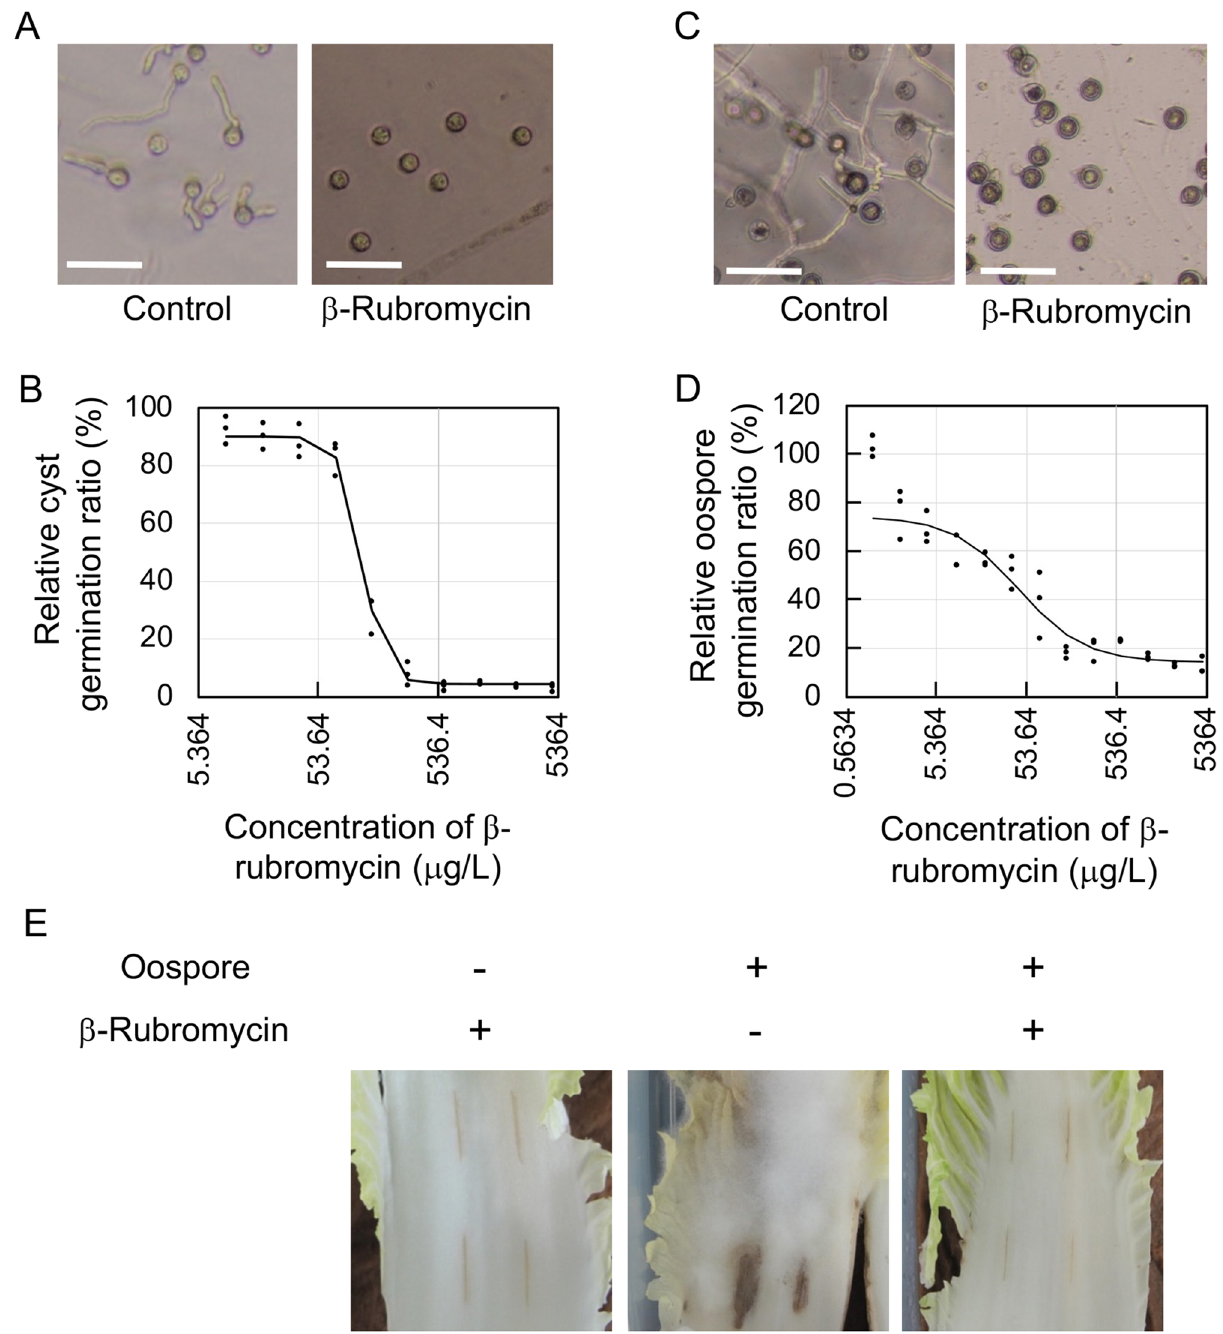
Figure 4. Effect of β-rubromycin on germination and in planta growth of Py. aphanidermatum . ( A ) Effect of 1.0 mg/L β-rubromycin on cyst germination. Representative data after 10 h at 18 °C are provided. Bar is 50 μM. ( B ) IC 50 of β-rubromycin for cyst germination at 10 h after cyst germination was stimulated. Each experiment was performed three times which contained three biological repeats. ( C ) Effect of 1.0 mg/L β-rubromycin on oospore germination after 24 h. Representative data are provided. Bar is 50 μM. ( D ) IC 50 of β-rubromycin for oospore germination after 24 h. Each experiment was performed three times which contained three biological repeats. ( E ) Effect of 1.0 mg/L β-rubromycin on in planta growth. Oospore (1.0 × 10 3 ) suspensions with or without 1.0 mg/L β-rubromycin were added to wounded Chinese cabbage leaves (four straight cuts per leaf). Representative images for three biological replicates at 4 days post-inoculation are